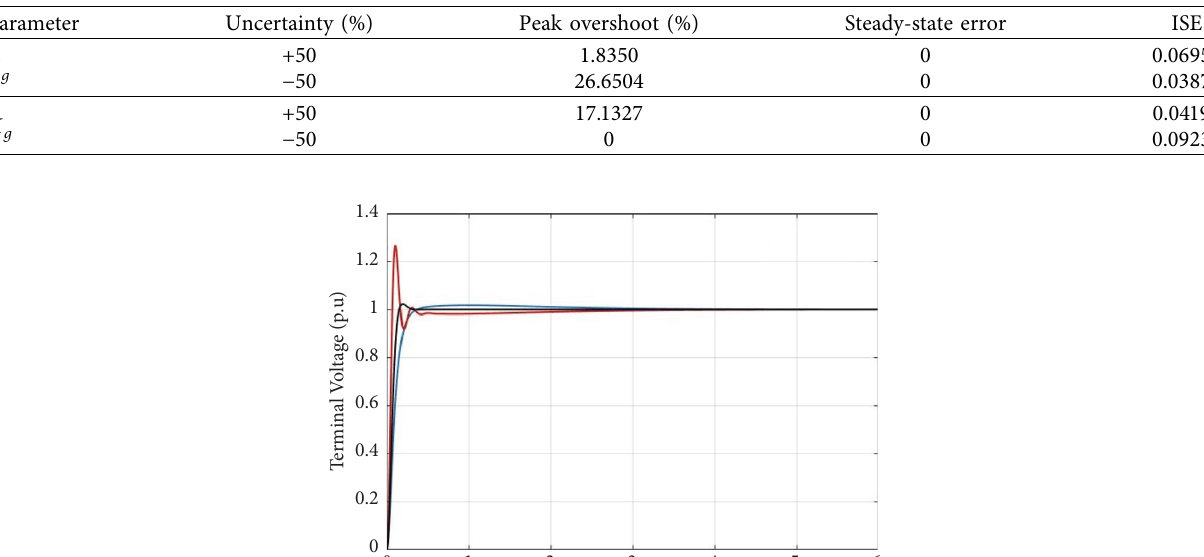
Figure 15: Response of terminal voltage using MESOBC for normal and ± 50% uncertainties in K Table 8: Robust response specifcation of MESOBC-based AVR under ± 50% uncertainties in generator.